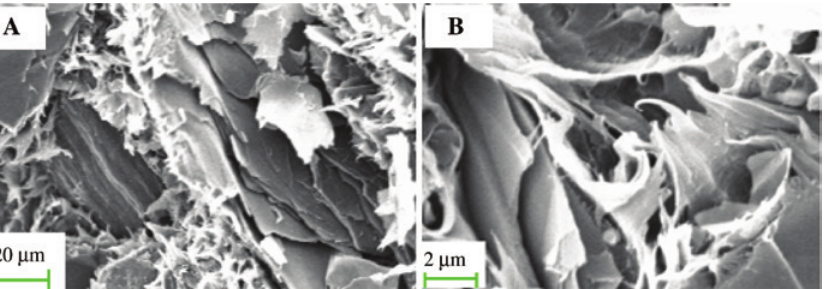
Figure 10: The SEM micrographs showing the fracture surface of the direct-mixed PP/SG at different magnifications shown at (A) and (B).